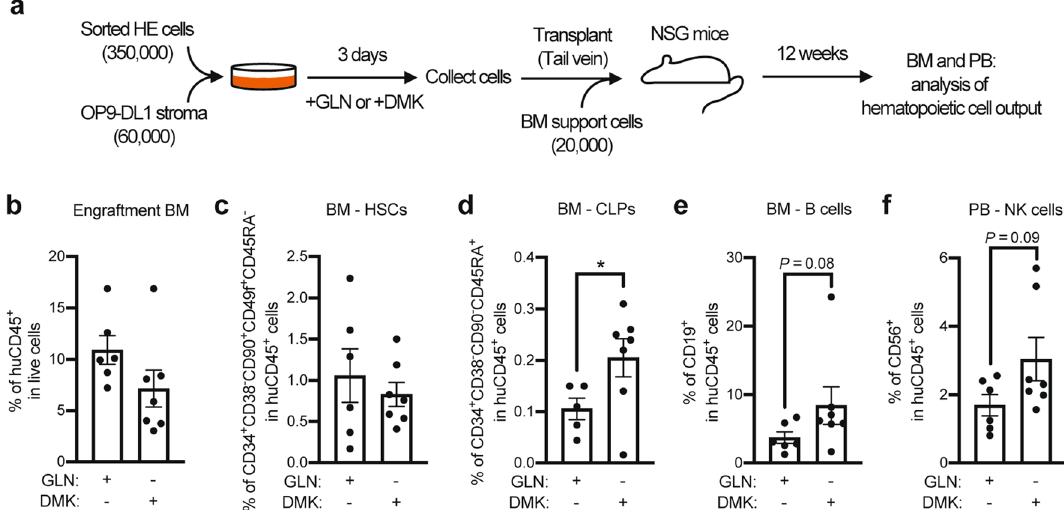
Figure 4. Boosting glutamine use for the TCA cycle via DMK in HE cells favors lymphoid repopulation in NSG mice. ( a ) Experimental design for in vivo assessment of HE cell potential. HE cells were co-cultured with OP9-DL1 stroma with glutamine (+GLN) or in glutamine-free medium with 1.75 mM DMK (+DMK) for 3 days and transplanted into sub-lethally irradiated NSG mice. Bone marrow (BM) and peripheral blood (PB) were harvested on week 12. ( b ) Engraftment levels in BM as percentages of huCD45 + cells are shown (+GLN, n = 6; +DMK, n = 7; from 2 independent experiments). The percentages ± s.e.m. of human HSCs ( c ), CLPs ( d ) and B cells ( e ) in huCD45 + cells from the BM are shown (+GLN, n = 6; +DMK, n = 7; unpaired t tests). ( f ) The percentages ± s.e.m. of human CD56 + NK cells in huCD45 + cells from the PB are shown (+GLN, n = 6; +DMK, n = 7; from 2 independent experiments; unpaired t tests). * p <